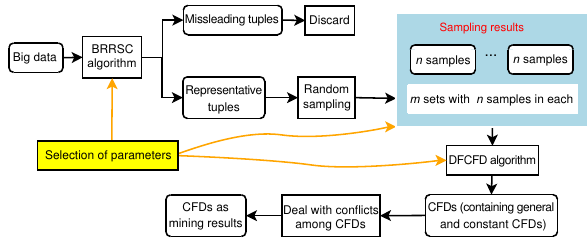
Fig. 1 Framework of the whole